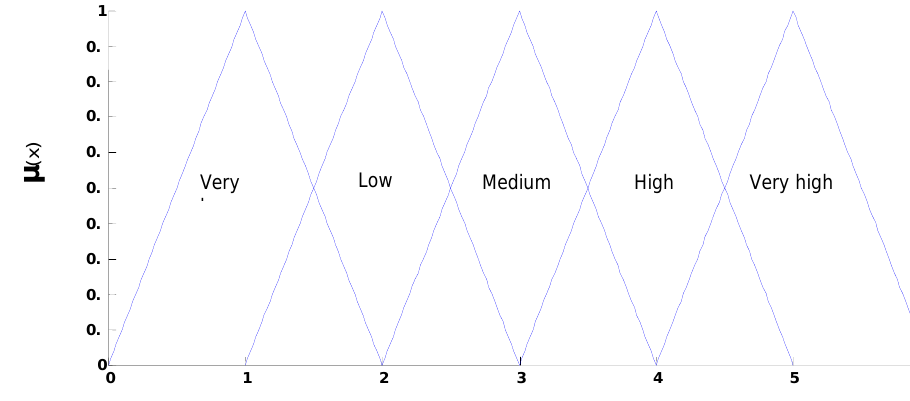
Figure 2: Graphical representation of alinguistic variable